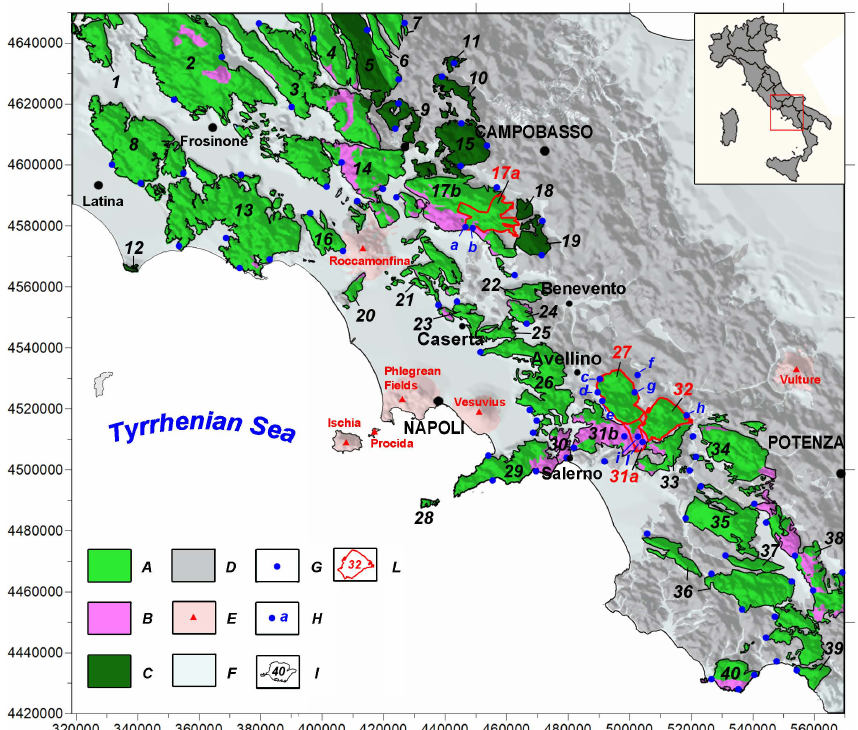
Fig. 1. Map of the karst aquifers of the southern Apennines. Key to symbols: (A) limestone and dolomitic limestone units of the carbonate platform series (Jurassic-Paleogene); (B) dolomitic units of the carbonate platform series (Trias-Liassic); (C) calcareous-marly units of the outer basin series (Trias-Paleogene); (D) pre-, syn- and late- orogenic molasses and terrigenous units (Cretaceous-Pliocene); (E) volcanic centers (Pliocene-Quaternary); (F) alluvial and epiclastic units (Quaternary); (G) main basal springs of karst aquifers; (H) basal karst springs considered in the hydrological budget (a and b: Maretto and Torano; c: Salza Irpina; d and e: Serino; f: Baiardo; g: Cassano Irpino; h: Sanità; i: Avella; l: Ausino-Ausinetto); (I) hydrogeological boundary and identification number of the karst aquifers; (L) hydrogeological boundary and identification number of the karst aquifers considered for the hydrological